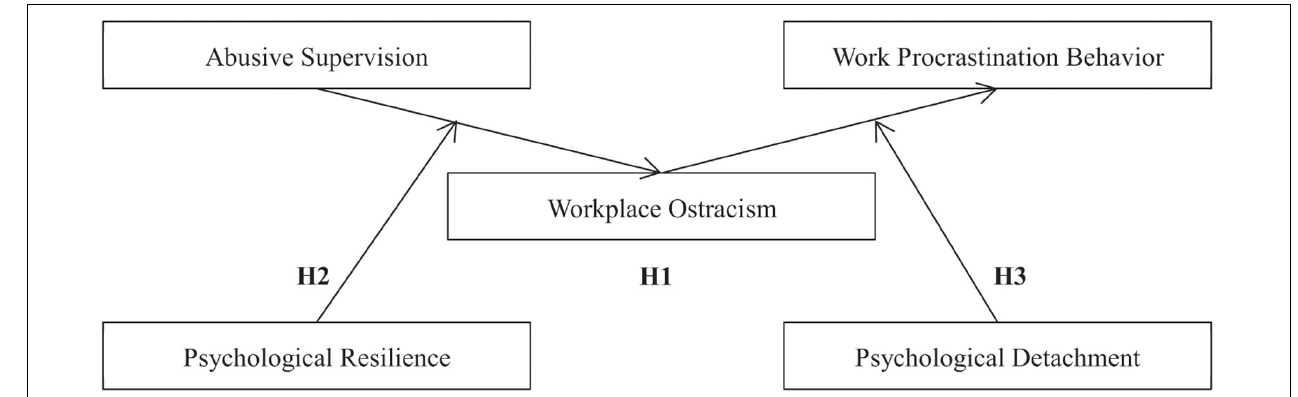
FIGURE 1 | Theoretical